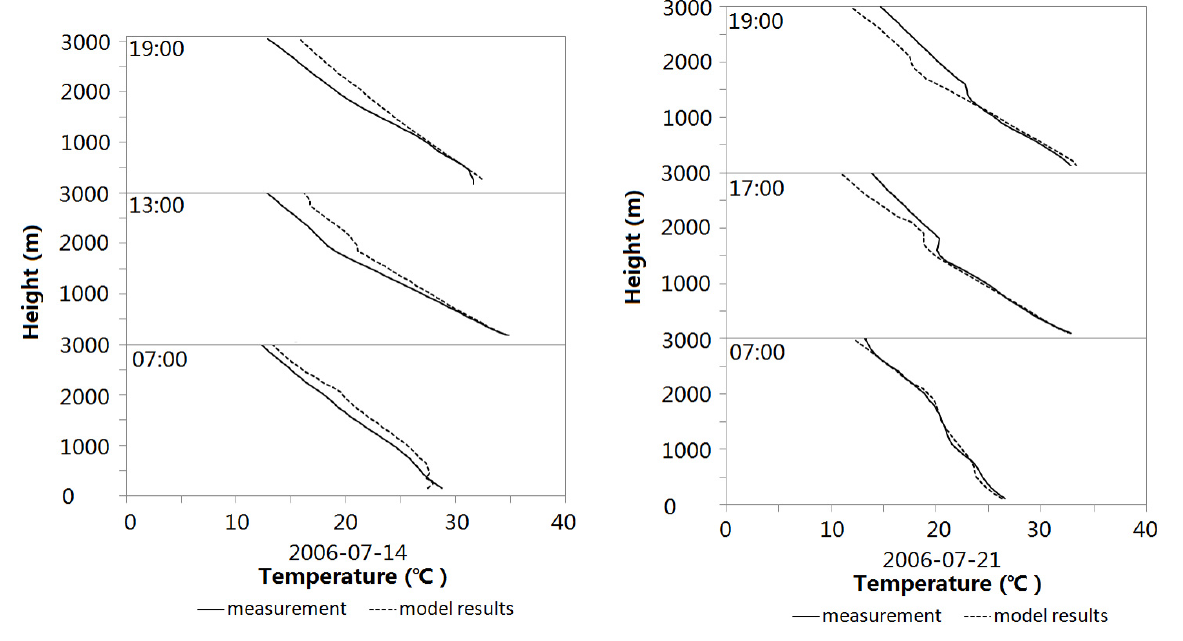
Fig. 9. Measured vertical temperature profile by radar soundings and the modeled results at Qingyuan station on 14 July and 21 July